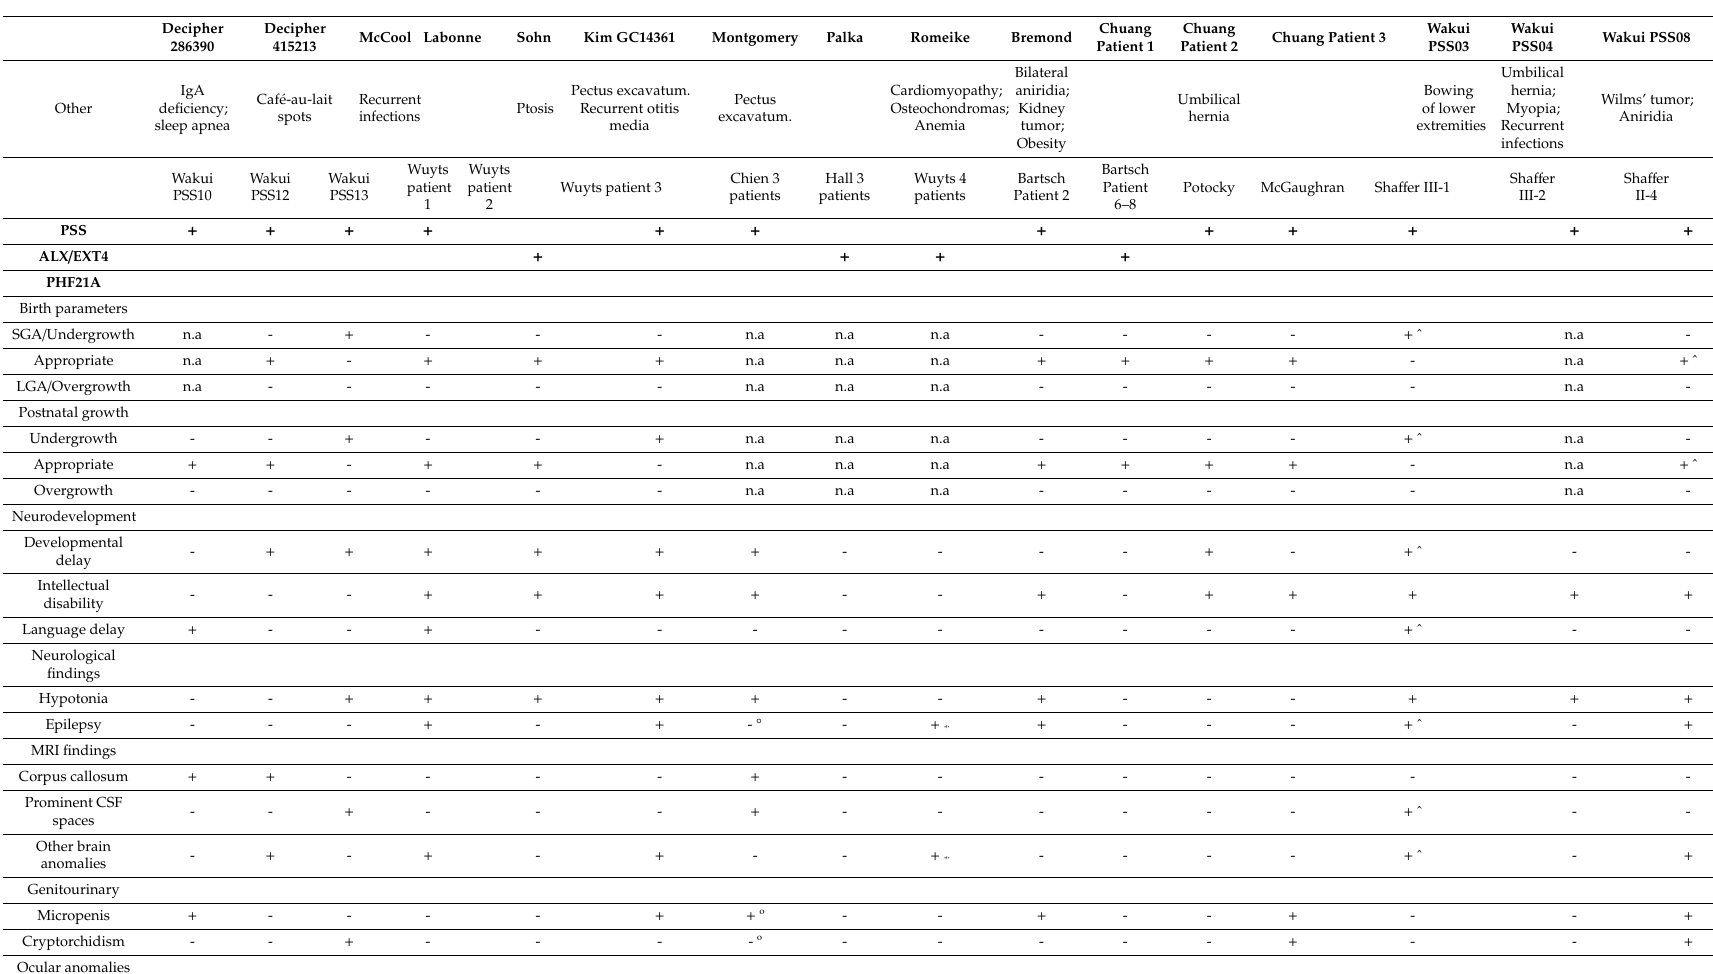
Cryptorchidism - - + - - - -º - - - - - + - - +